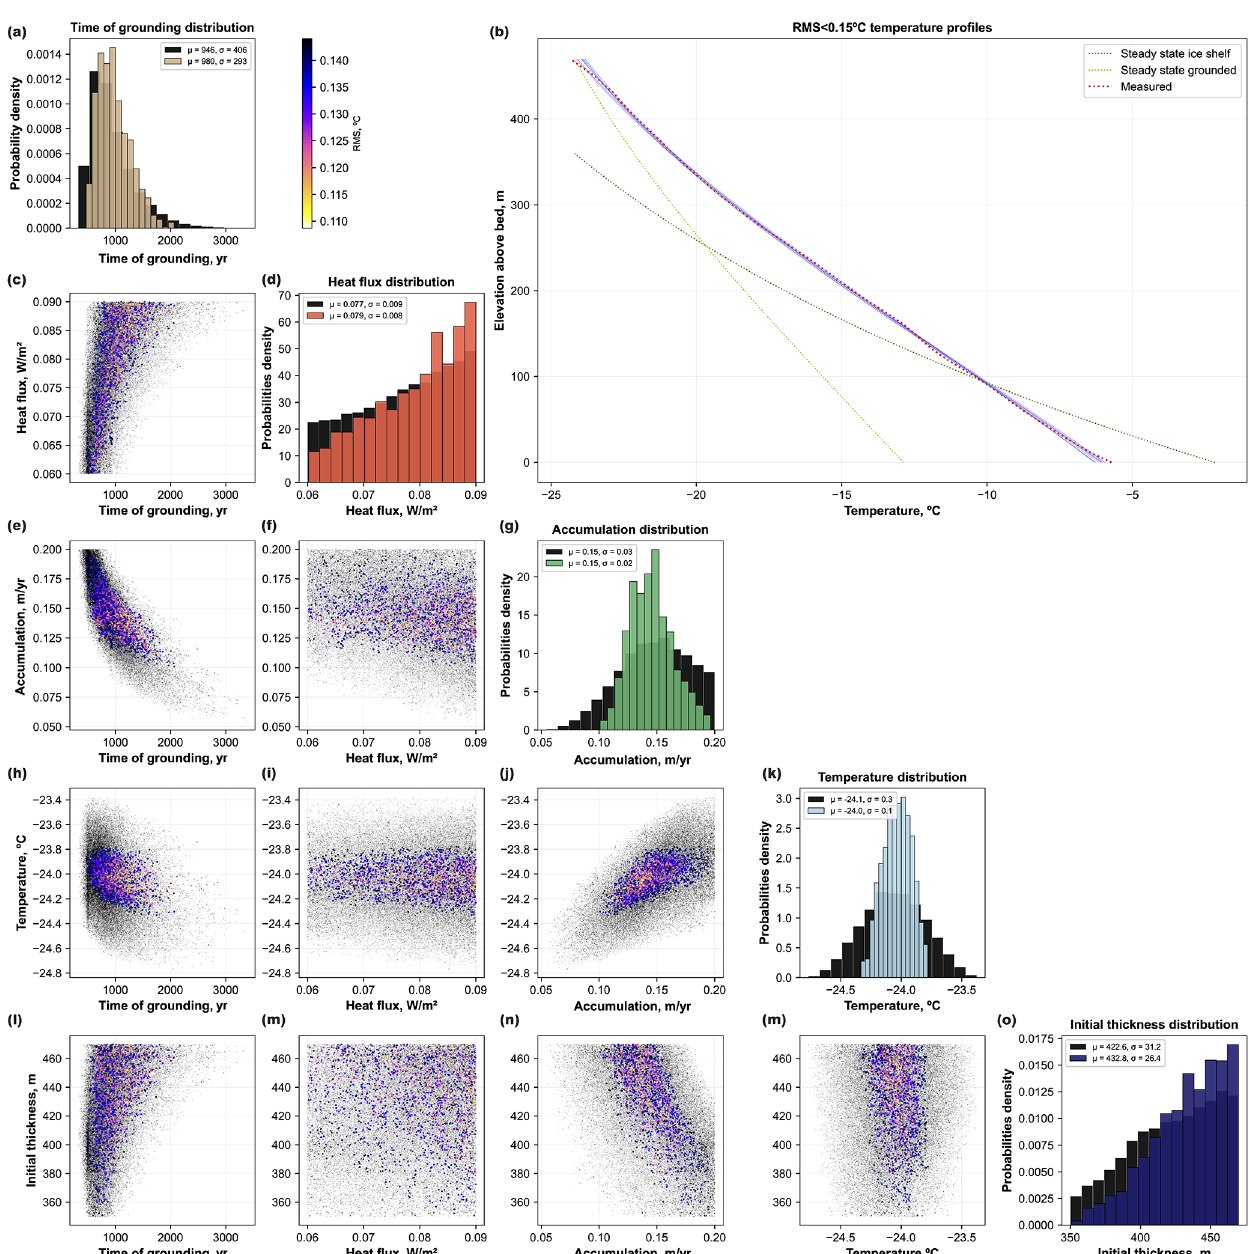
Figure 4. Inversion of the temperature–depth measurements near Crary Ice Rise Site D. Grey cloud of points illustrates the random walk in the parameter space, showing the tested combinations of parameter values that yielded a less than 0.3 ◦ C rms misfit with observations, while the coloured data points show the combination of parameter values that yields best-fit with measured temperature profile (i.e. less than 0.15 ◦ C rms). The colour of the points indicate the rms. Diagonally placed histograms (a, d, j, k, p) show posterior distributions for each parameter: black bars show parameter distributions that yielded rms < 0.3 ◦ C rms; coloured bars show distributions of parameter values that yielded best-fit with measured temperature profile (i.e. < 0.15 ◦ C rms). Insets in histograms display the mean, µ , and standard deviation, σ , of each distribution. (b) Randomly selected resultant temperature profiles for 0.3 and 0.15 ◦ C rms